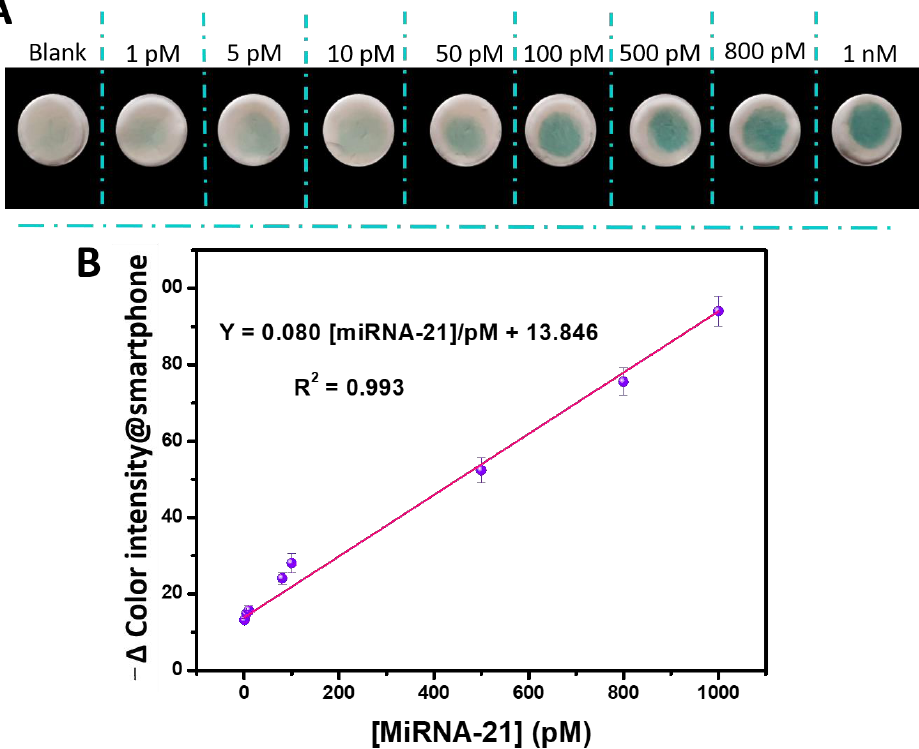
Figure 4. ( A ) The visual incremental color change observed for the paper-based genosensor ranging from 1 pM to 1 nM of miRNA-21. ( B ) Calibration plots of color intensities (I target − I blank ) against different miRNA-21 concentrations ranging from 1 pM to 1 nM. Three parallel experiments yielded error bars.